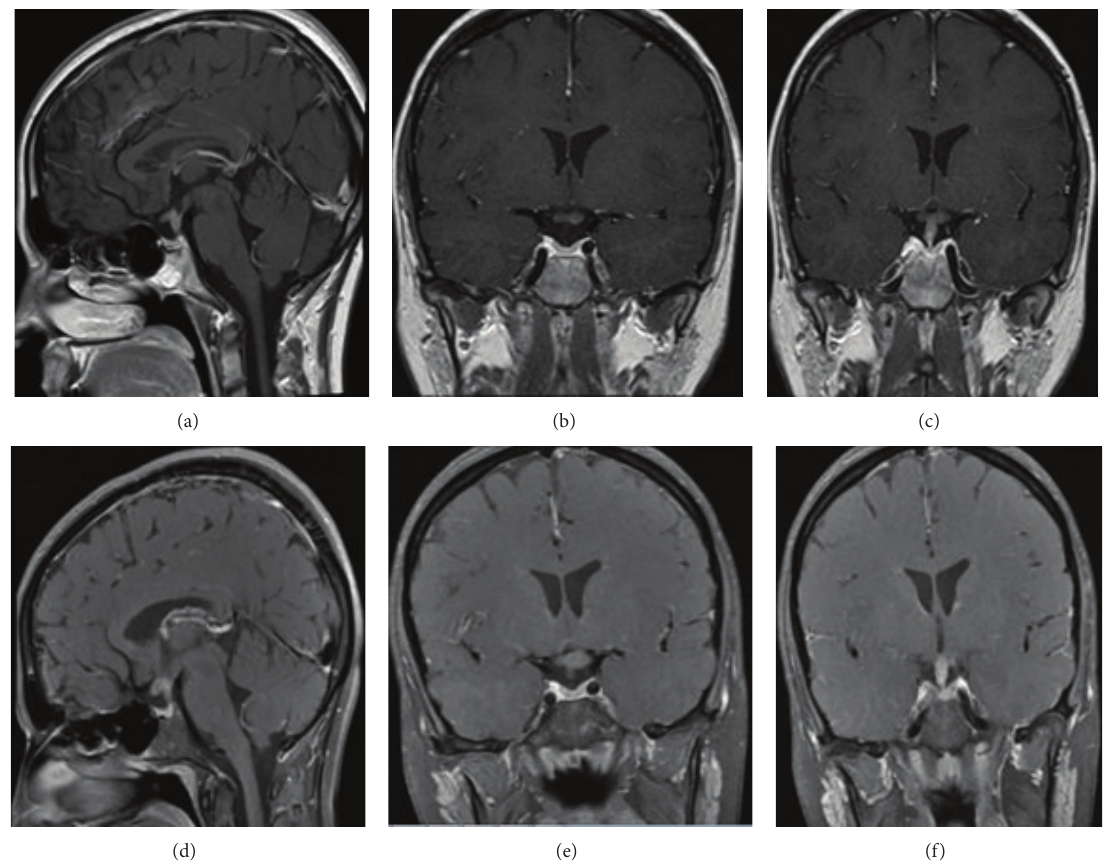
Figure 2: Comparison of MRI pituitary with and without contrast images between initial evaluation and follow-up evaluation. At the initial evaluation ((a) Sagittal slice; (b) and (c) Coronal slices), the pituitary infundibulum thickening was seen with minimal involvement of optic chiasm. At the follow-up evaluation 3 months later ((d) Sagittal slice; (e) and (f) Coronal Slices), abnormal enlargement and enhancement of infundibulum worsened with progressive involvement of left aspect of optic chiasm and proximal portion of left optic